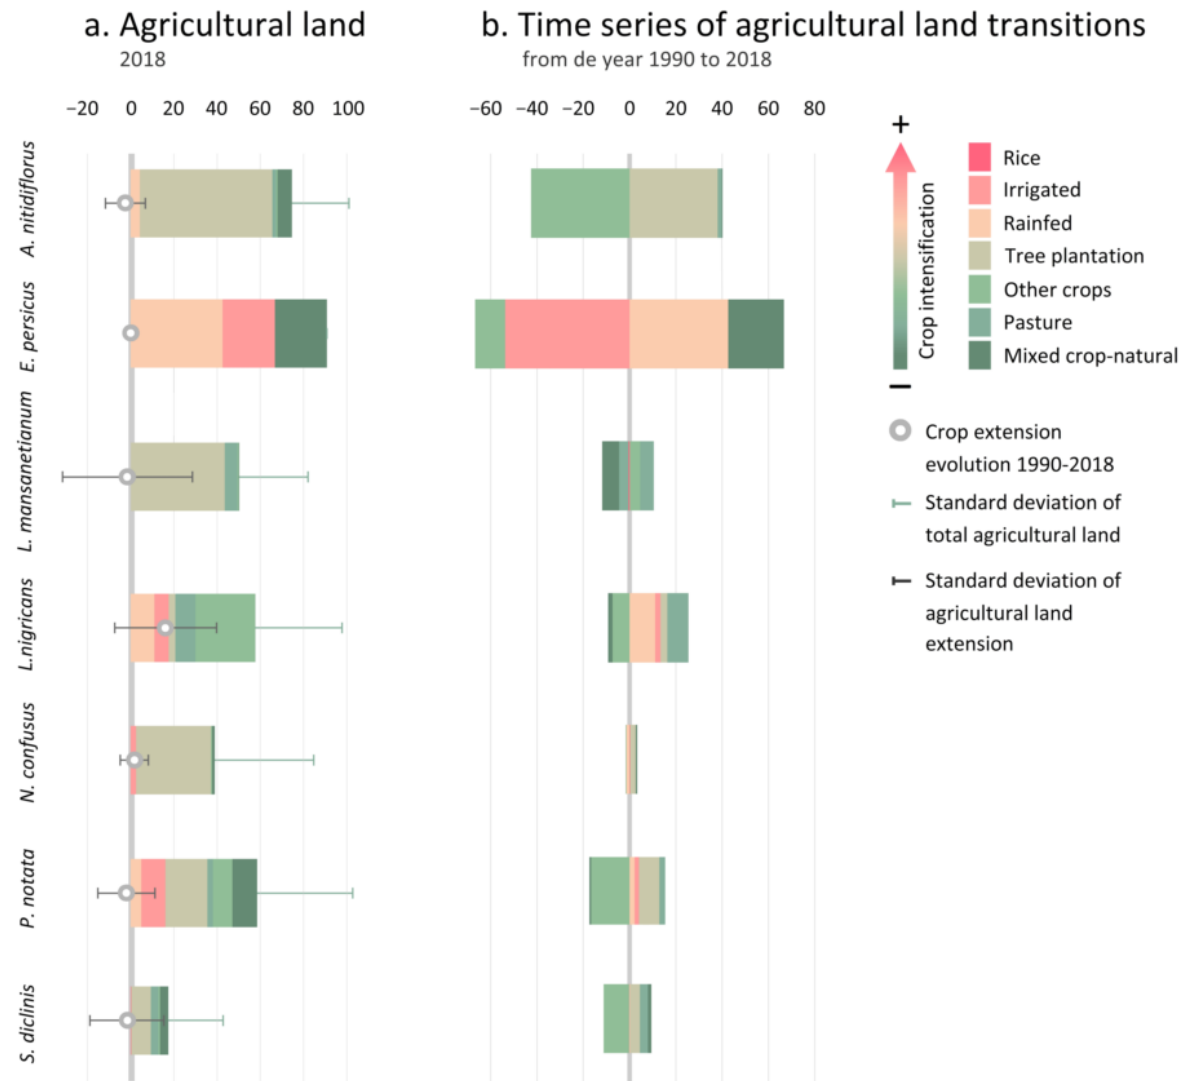
Figure 3. Taxa threatened by crop intensification. ( a ) Agricultural land. The figure shows the total area of agricultural uses according to CORINE of the area of influence of taxa threatened by crop intensification in 2008. The dot indicates the evolution of the area of agricultural use for each taxon between 1990 and 2018. ( b ) Time series of agricultural uses. The figure shows, for each taxon, the trend of expansion or reduction of agricultural use between 1990 and 2018, according to CORINE.